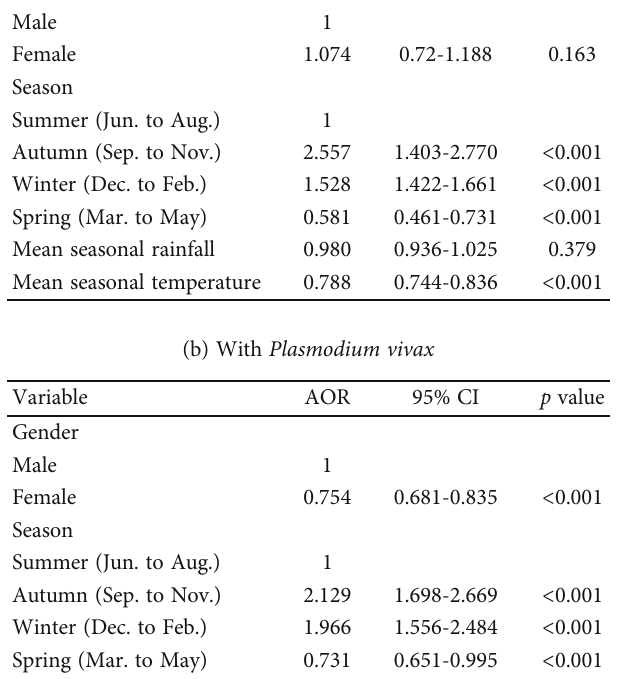
mean seasonal temperature and mean seasonal rainfall Table 4: Binary logistic regression analysis of factors associated